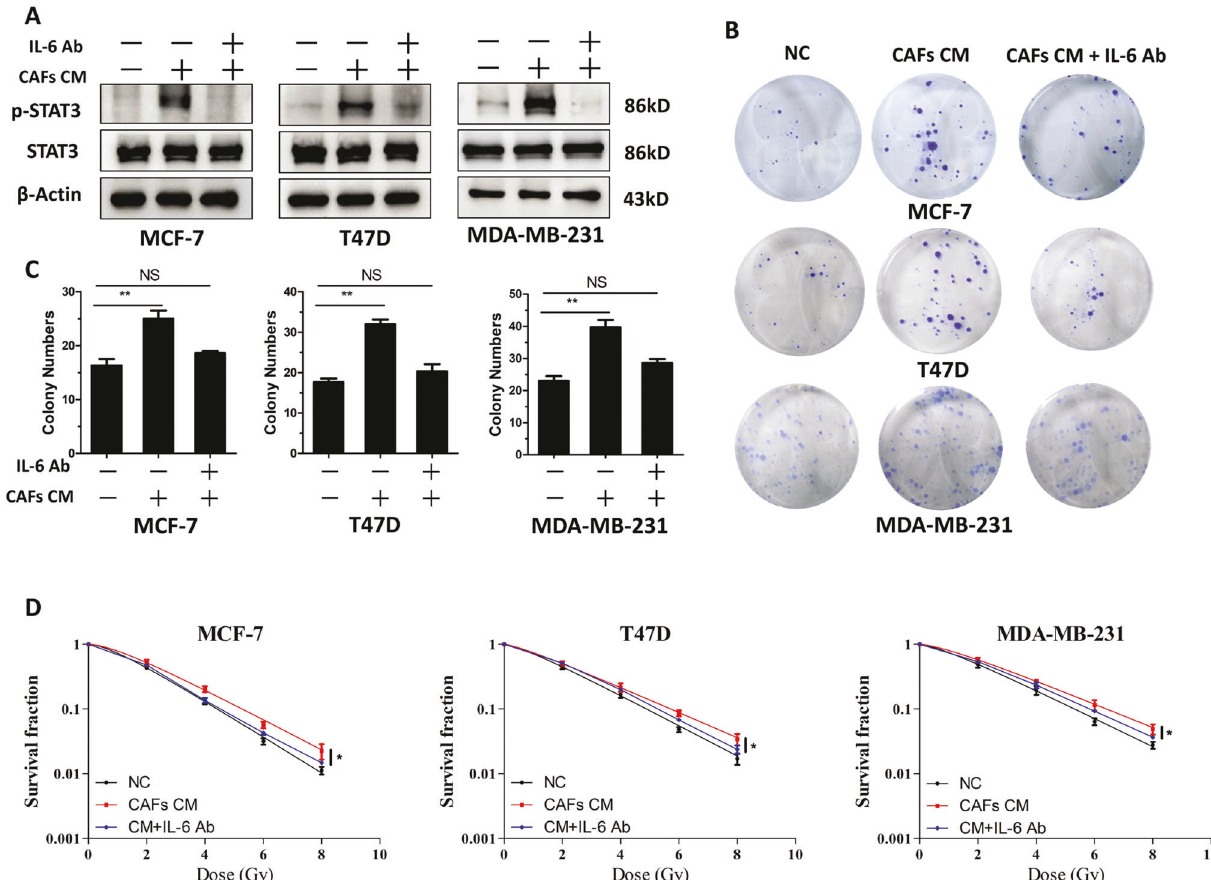
Fig. 4 IL-6 neutralizing antibodies blocked the growth and radioresistance induced by CAFs. A Western blotting analysis of STAT3 and p-STAT3 levels in T47D, MCF-7, and MDA-MB-231 cells. CAF conditioned medium alone or in combination with IL-6 neutralizing antibody (500 ng/ml) was used to treat the cells. B , C Colony formation assay showing that treatment with IL-6 neutralizing antibodies blocked the cell growth induced by CAFs. D Clonogenic survival assays showing that treatment with IL-6 neutralizing antibodies abrogated the radioresistance induced by CAFs. Results are displayed as means ± SD, n = 3, * P < 0.05, ** P <